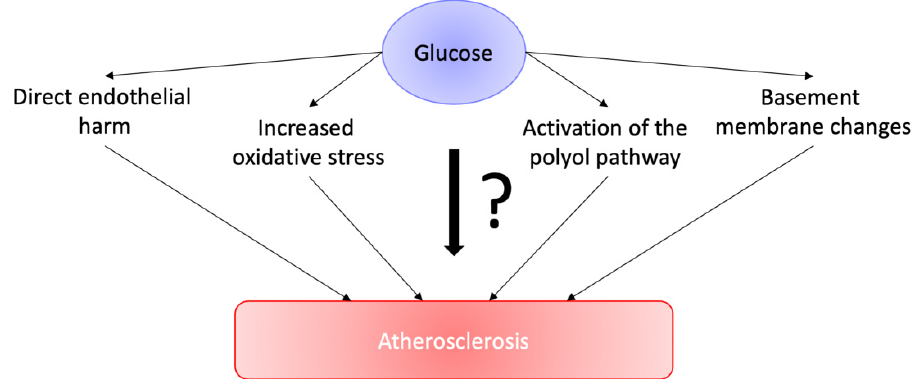
Figure 1. Potential relationship between glucose and atherosclerosis.